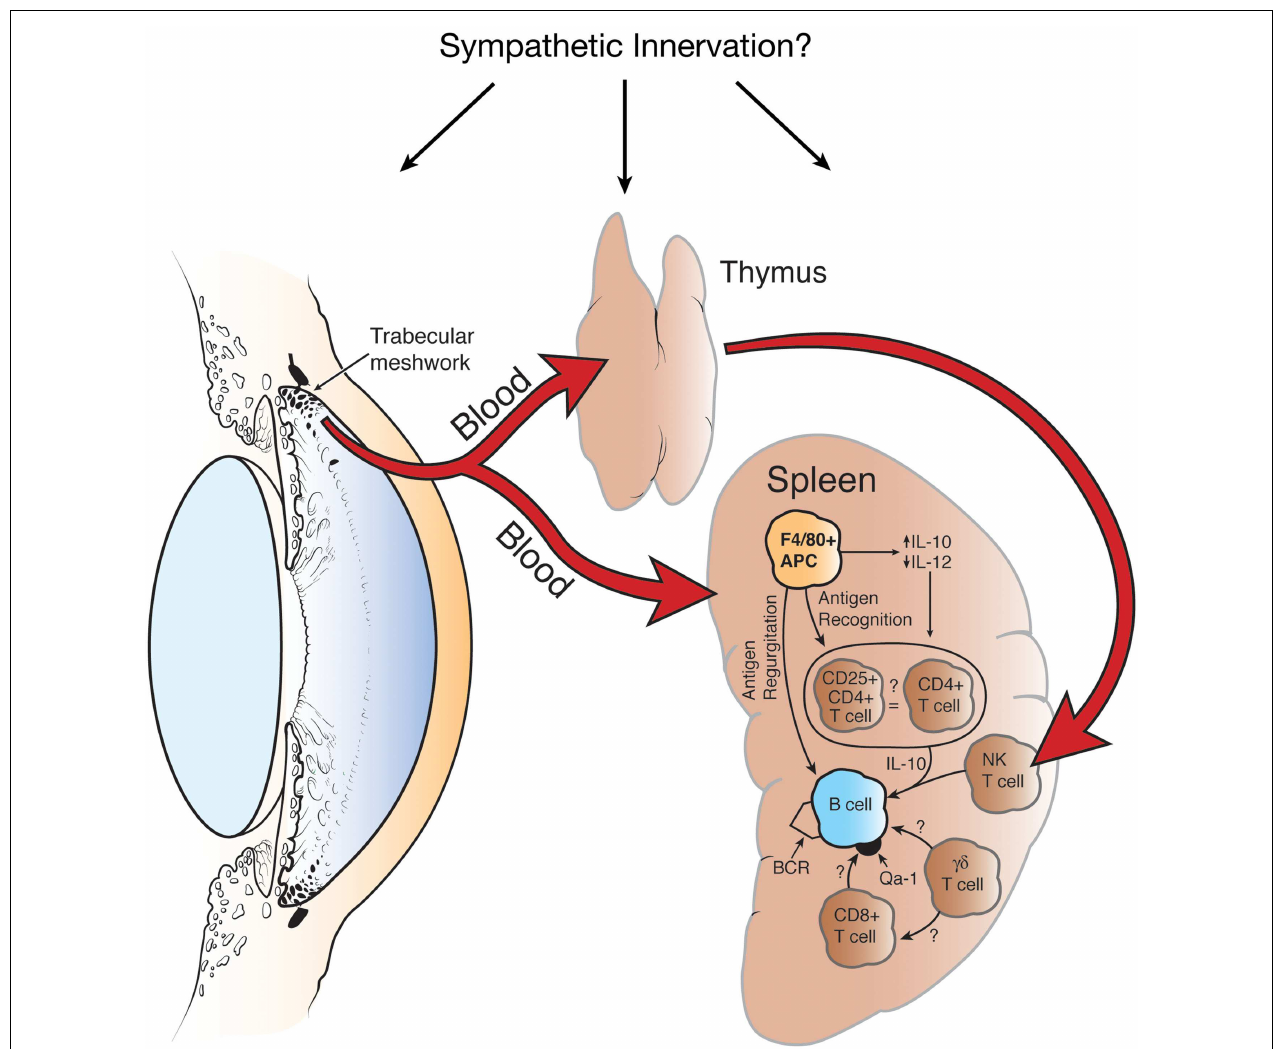
injecting antigen into the anterior chamber also abrogates ACAID. BCR, B cell receptor. Reproduced from Niederkorn (2006), with permission from Nature Publishing